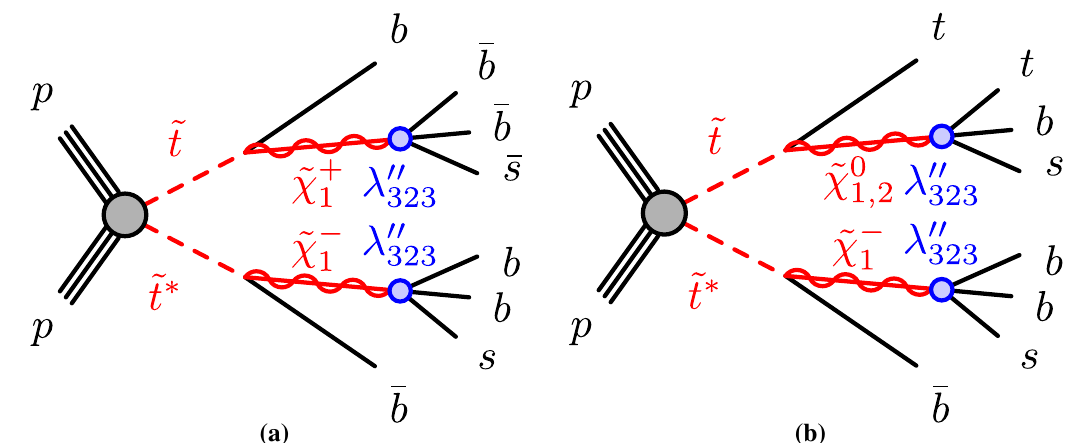
Fig. 1 Diagrams of the signal processes involving pair production of top squarks ˜ t : a with the decay into a b -quark and the lightest chargino ˜ χ + ( ˜ t → b ˜ χ + ) with the subsequent decay of the chargino ˜ χ + 1 1